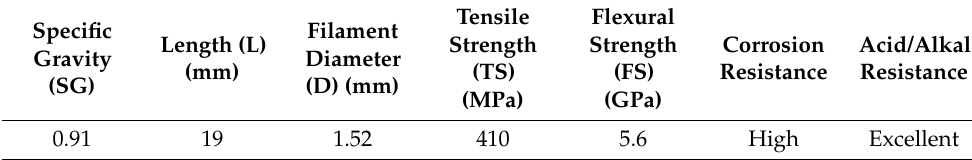
Table 2. Polypropylene fiber properties.